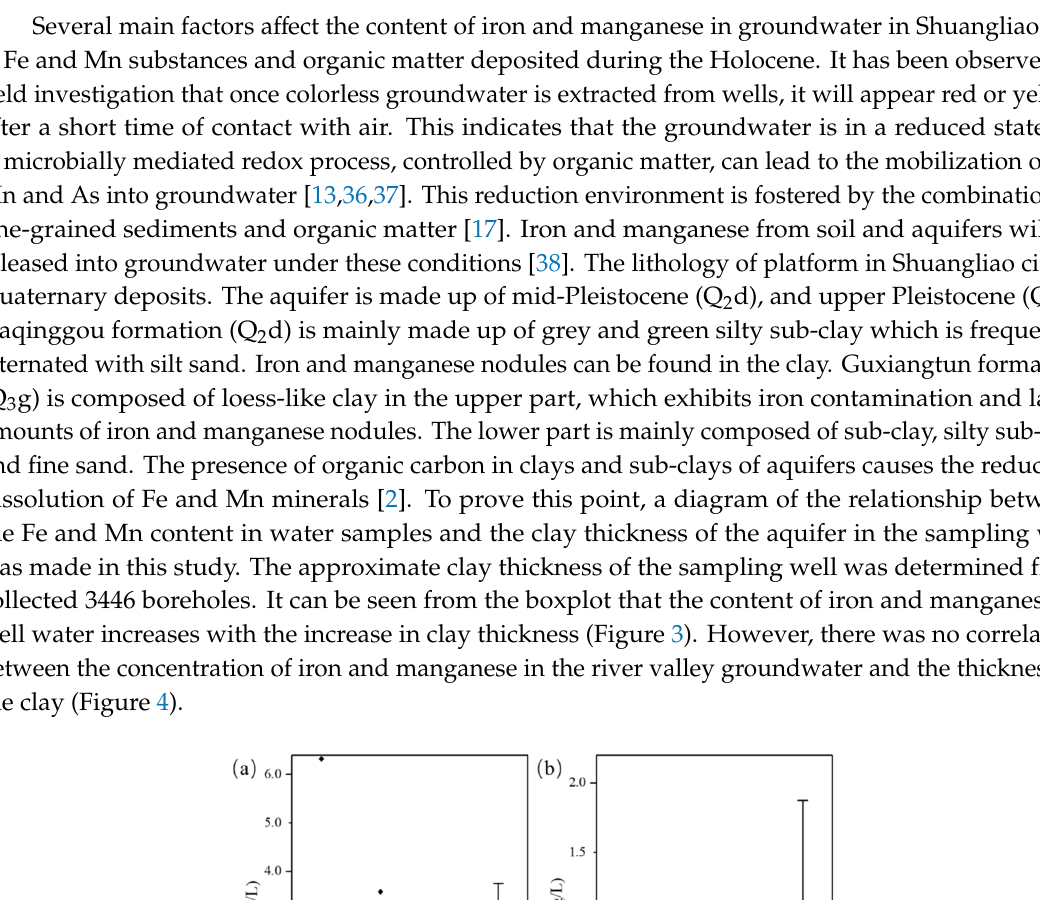
Table 5. Varimax rotated R-mode factor loading matrix for groundwater of the river valley.